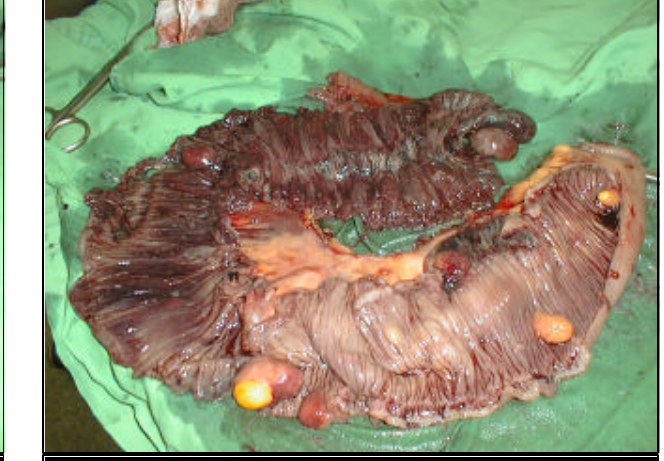
Fig. 1 : Gross specimen after reduction. Fig. 2 : Cut specimen, multiple submucosal